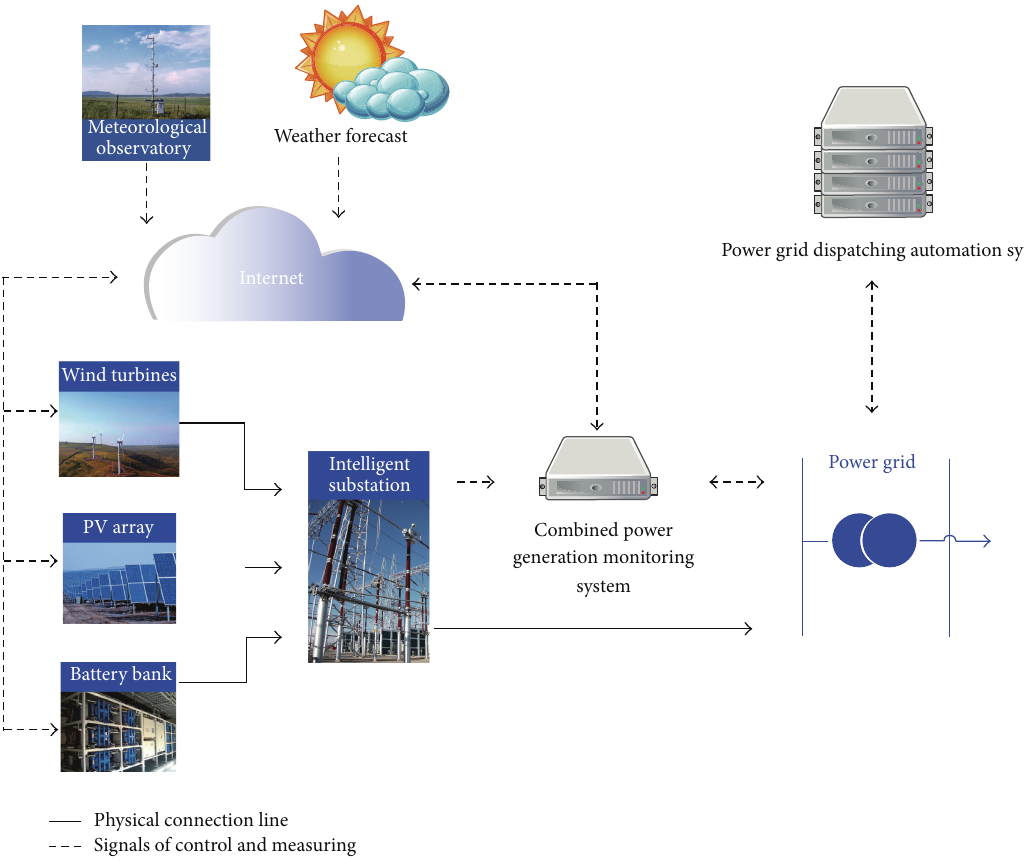
Figure 1: Basic structure of wind-PV-battery